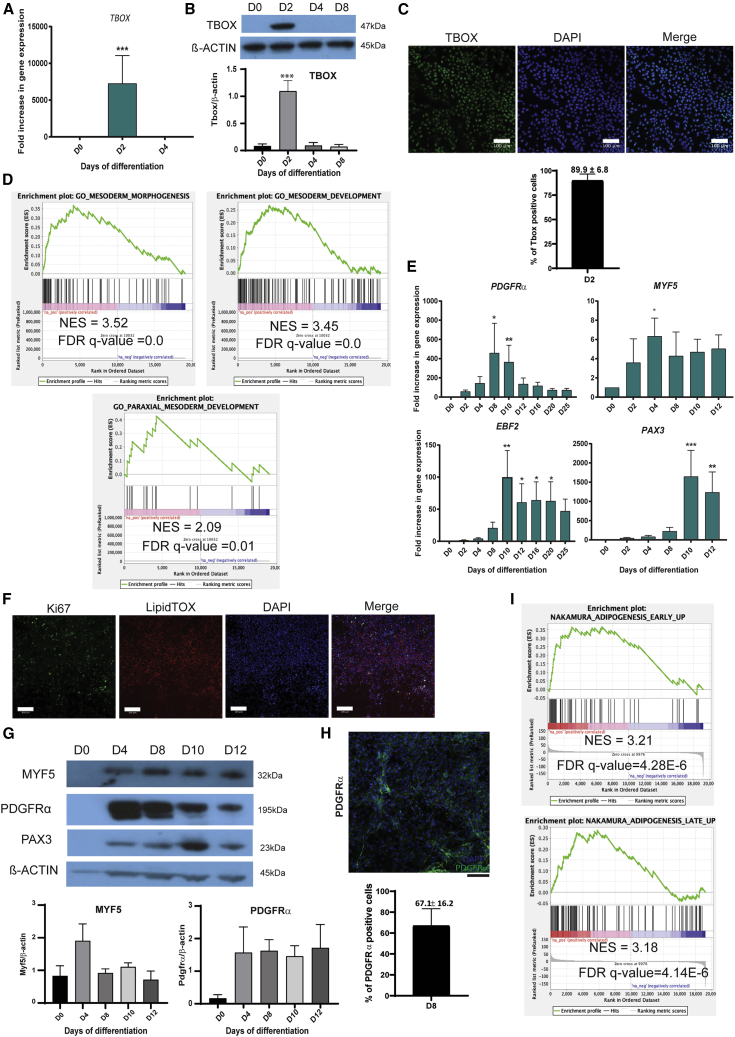
Differentiation of induced pluripotent stem cells into mesoderm and adipose progenitors(A) qRT-PCR analysis of expression of the mesodermal marker TBOX in H9-derived mesodermal precursor cells (mean ± SEM arbitrary units [A.U.] relative to D0; n ≥ 3 independent experiments; ∗∗∗p < 0.001 relative to D0). GAPDH was used as the housekeeping gene (∗∗∗p < 0.001 relative to D0).(B) Detection of TBOX in H9-derived mesodermal precursors from D0 to D8 by western blot (WB). β-Actin was used as loading control. Western blot quantification is shown underneath the WB image.(C) TBOX immunostaining of H9-derived mesodermal progenitors at D2 (green). Nuclei were stained with DAPI (blue). Scale bars, 100 μm. TBOX-positive cells were quantified using CellProfiler (SEM ± mean, n = 3 technical replicates).(D) GSEA of H9-derived cells on D4 versus D0 using GSEA (n = 3 independent experiments), using the "mesoderm morphogenesis" GO: 48332, "mesoderm development" GO: 0007498, and "paraxial mesoderm development" GO: 0048339 datasets.(E) qRT-PCR analysis of the expression of the indicated genes from D0 to D12 in H9-derived cells. Data are shown as mean ± SEM A.U. relative to D0; n ≥ 3 experiments; ∗p < 0.05, ∗∗p < 0.01, ∗∗∗p < 0.005 relative to D0. GAPDH as housekeeping gene.(F) Ki67 immunostaining of H9-derived adipose progenitors at D12 (green). Nuclei were stained with DAPI (blue). LipidTOX was used to stain the lipid droplets (red). Scale bars, 100 μm.(G) Detection of MYF5, PDGFRα, and PAX3 in differentiating H9 on D0, D4, D8, D10, and D12 by western blot. β-Actin was used as the loading control. Western blot quantification showed underneath the WB image.(H) PDGFRα immunostaining of H9-derived paraxial mesodermal progenitors at D8 (green). Nuclei were stained with DAPI (blue). Scale bars, 100 μm. PDGFRα-positive cells were quantified using CellProfiler (SEM ± mean, n = 3 biological replicates).(I) GSEA of H9-derived adipose progenitor cells using published datasets ("Nakamura adipogenesis early up" and "Nakamura adipogenesis late up"), with early and late adipogenesis transcriptomic signatures on D12 versus D0, compared with human adult adipose stromal cell signature (n = 3 independent experiments).